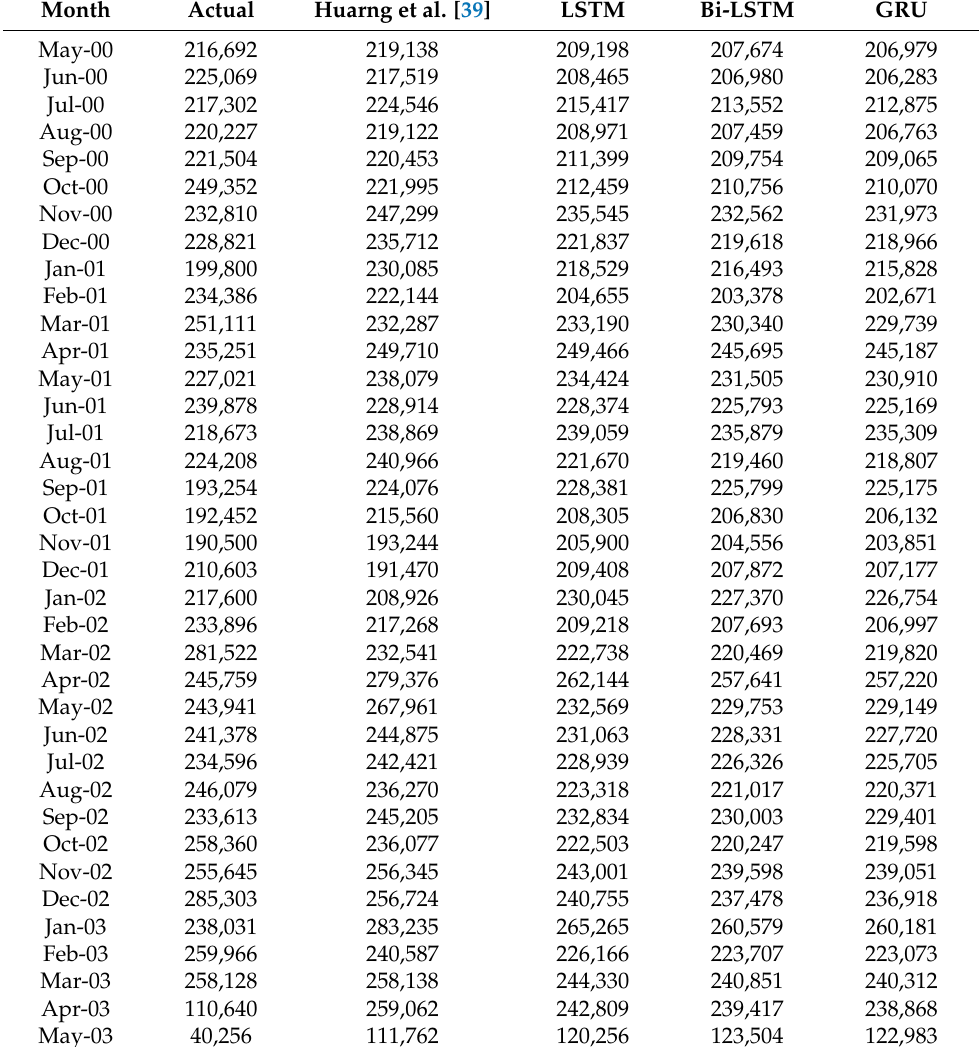
Table 1. Comparison of